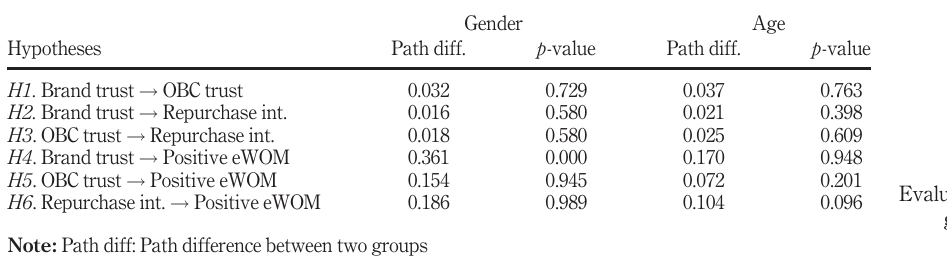
Table 5. Evaluation of